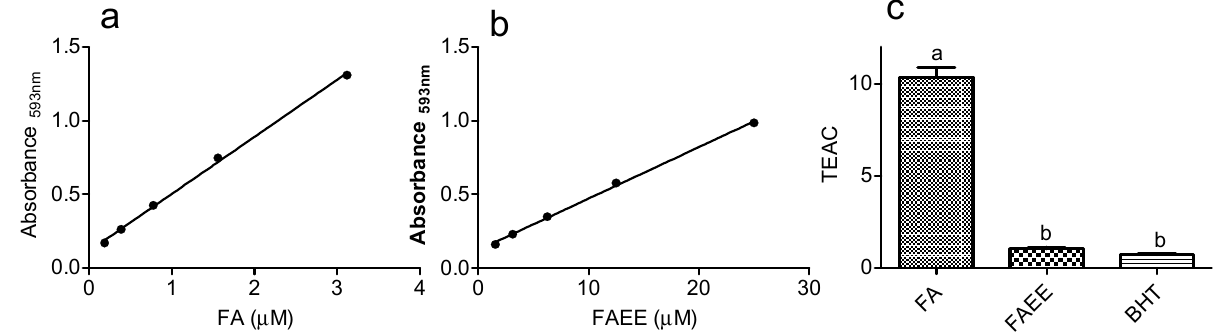
Figure 3. Ferric reducing capacity (FRAP assay). ( a , b ) Linear relationship between the concentration of the tested compounds and absorbance of the complex Fe(II)-TPTZ. From the liner regression curves the slopes were calculated. ( c ) Trolox equivalent antioxidant activity (TEAC = slope compound/slope trolox). The results are mean and SD of triplicate. Different letters denotes significant differences. One-Way Anova and Tukey’s Multiple Comparison Test ( p < 0.05).